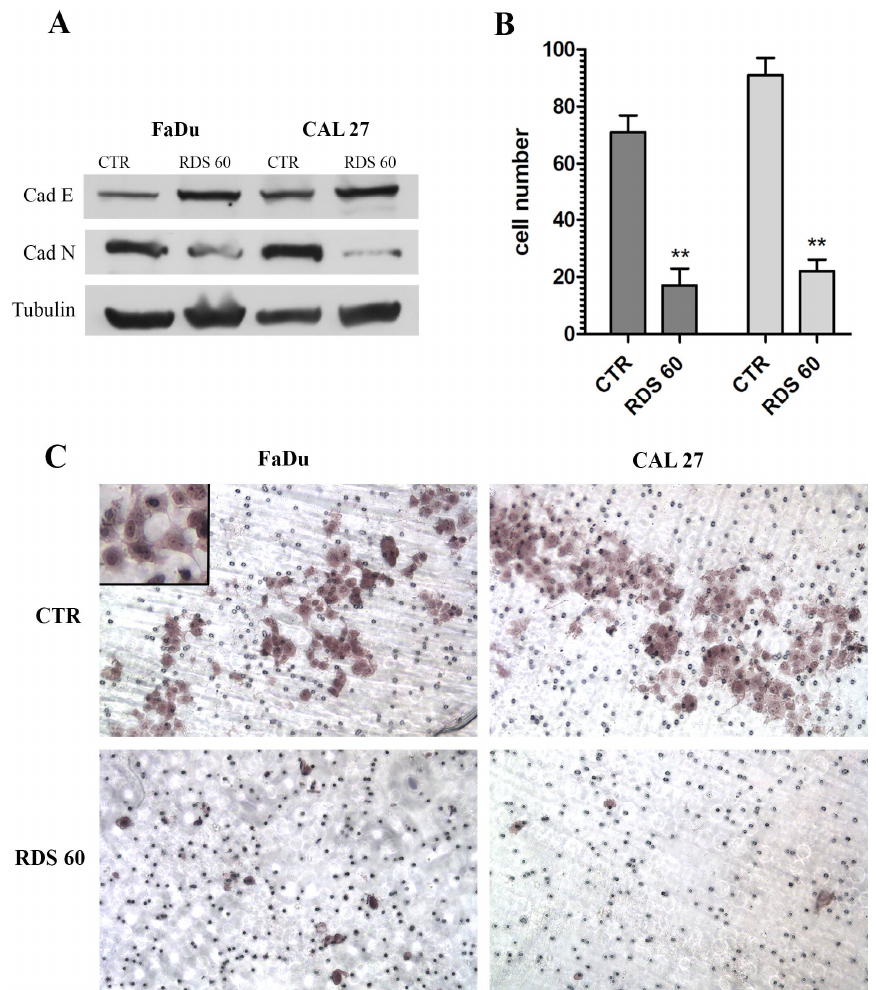
Figure 5. EMT reversion and migration inhibition of HNSCC cell lines induced by RDS 60. ( A ) Western blot of EMT related proteins E-cadherin and N-cadherin from untreated (CTR) and 1 µ M RDS 60 treated for 24 h FaDu and CAL27. ( B ) Graphic representing the number of migrated cells in five random fields from three independent experiments of Matrigel invasion assay with the means ± SD; ** p < 0.001. ( C ) Matrigel invasion assay of untreated FaDu and CAL27 cells (CTR) and 1 µ M RDS 60 treated cells for 16 h. The higher magnification insert on the top left angle shows morphological heterogeneity and mesenchymal phenotype of untreated